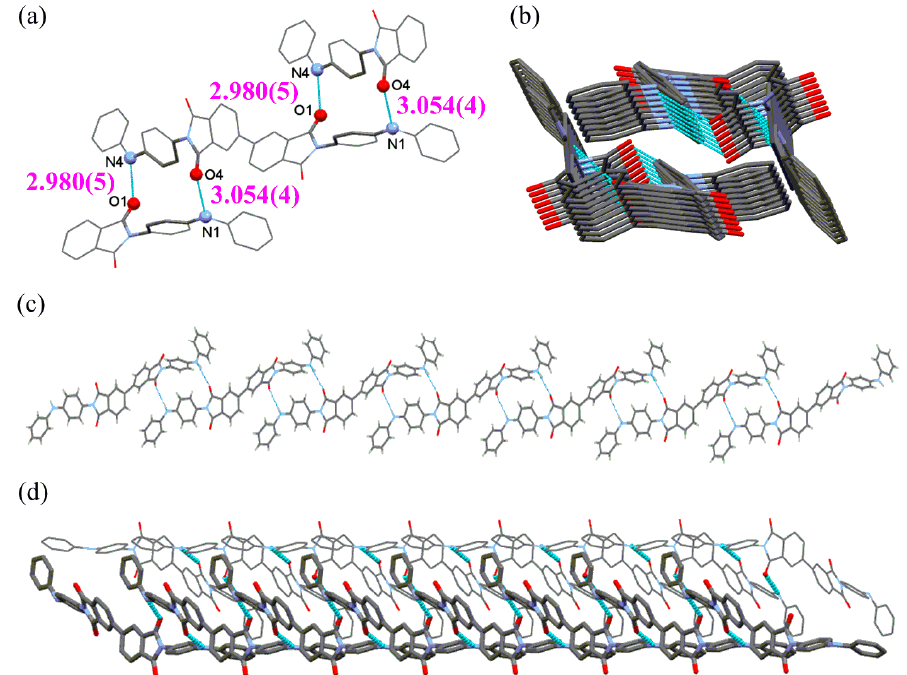
Figure 4. Perspective views for 3 formed by intermolecular N ··· O hydrogen bonds ( a – d ) are presented. A small pore was formed by two molecules with non-equivalent two types of N ··· O hydrogen bonds ( a ). Views of a single 1D chain ( c ), and double chains ( b , d ) for 3 are presented. The greenish blue dashed line represents intermolecular N ··· O hydrogen bonds.